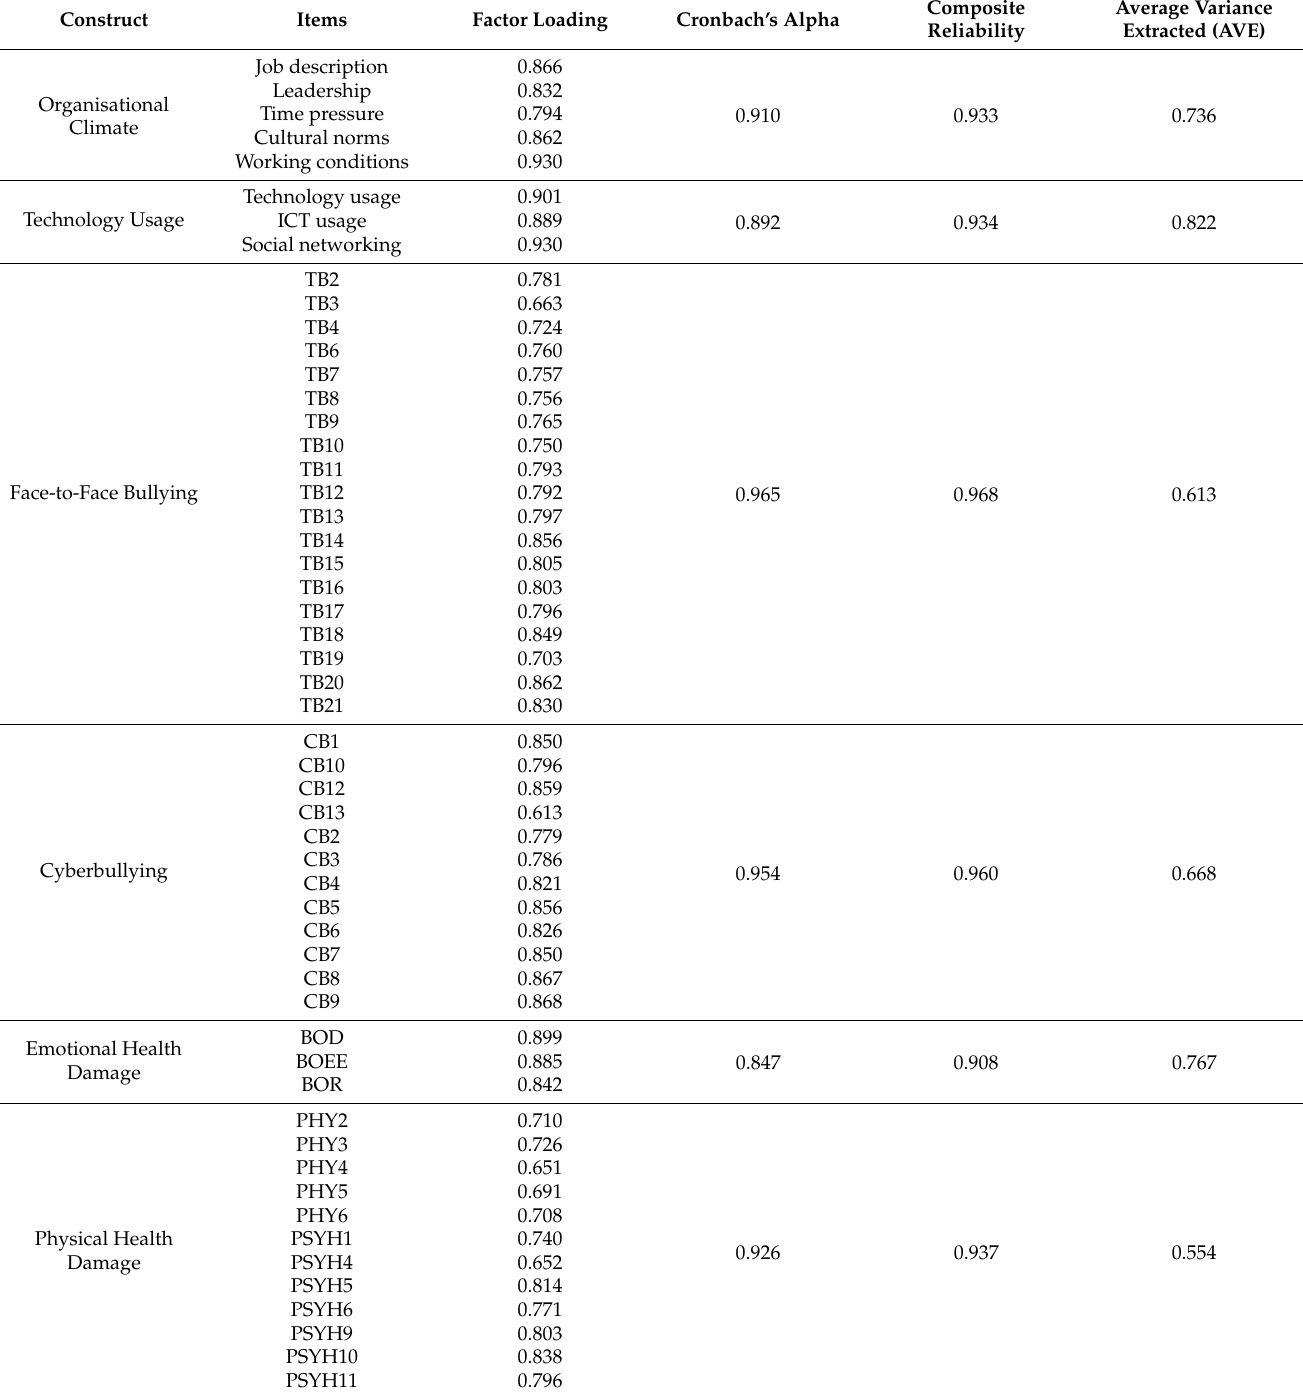
Table 1. Construct reliability, composite reliability and convergent